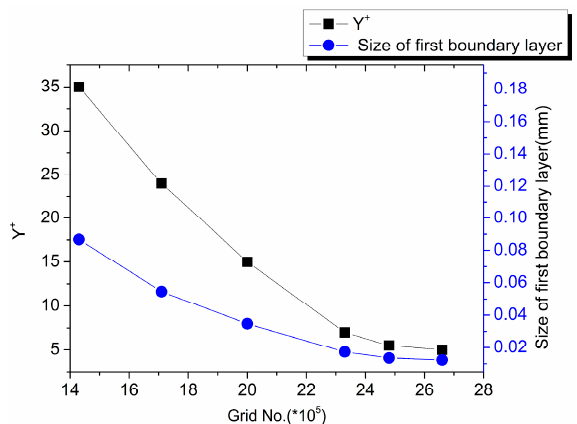
Figure 3. Grid System of the centrifugal pump. ( a ) Overall view; and ( b ) magnified view of the volute tongue.